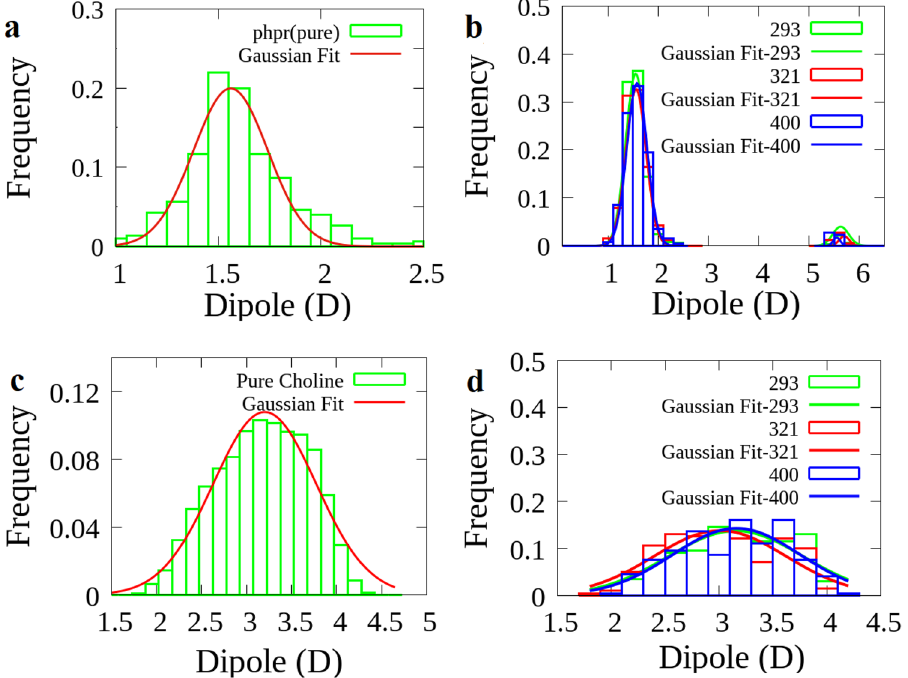
Figure 7. The normalized-distribution of molecular dipole moment vector of Phpr in a pure state; ( a ), in DES system; ( b ), and the normalized-distribution of choline cation in pure choline chloride system; ( c ) and in DES system; ( d ) The data were fitted using Gnuplot 5.2.6 (http:// www. gnupl ot. info/).